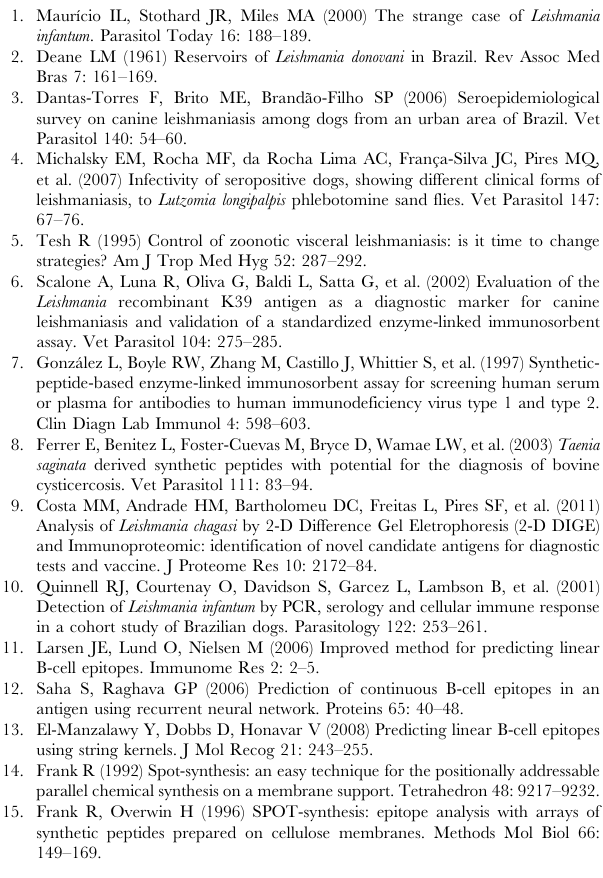
Table S1 Peptides with relative intensity (RI) equal or greater than 2. Table S2 Reactivity of serum samples to 48 different